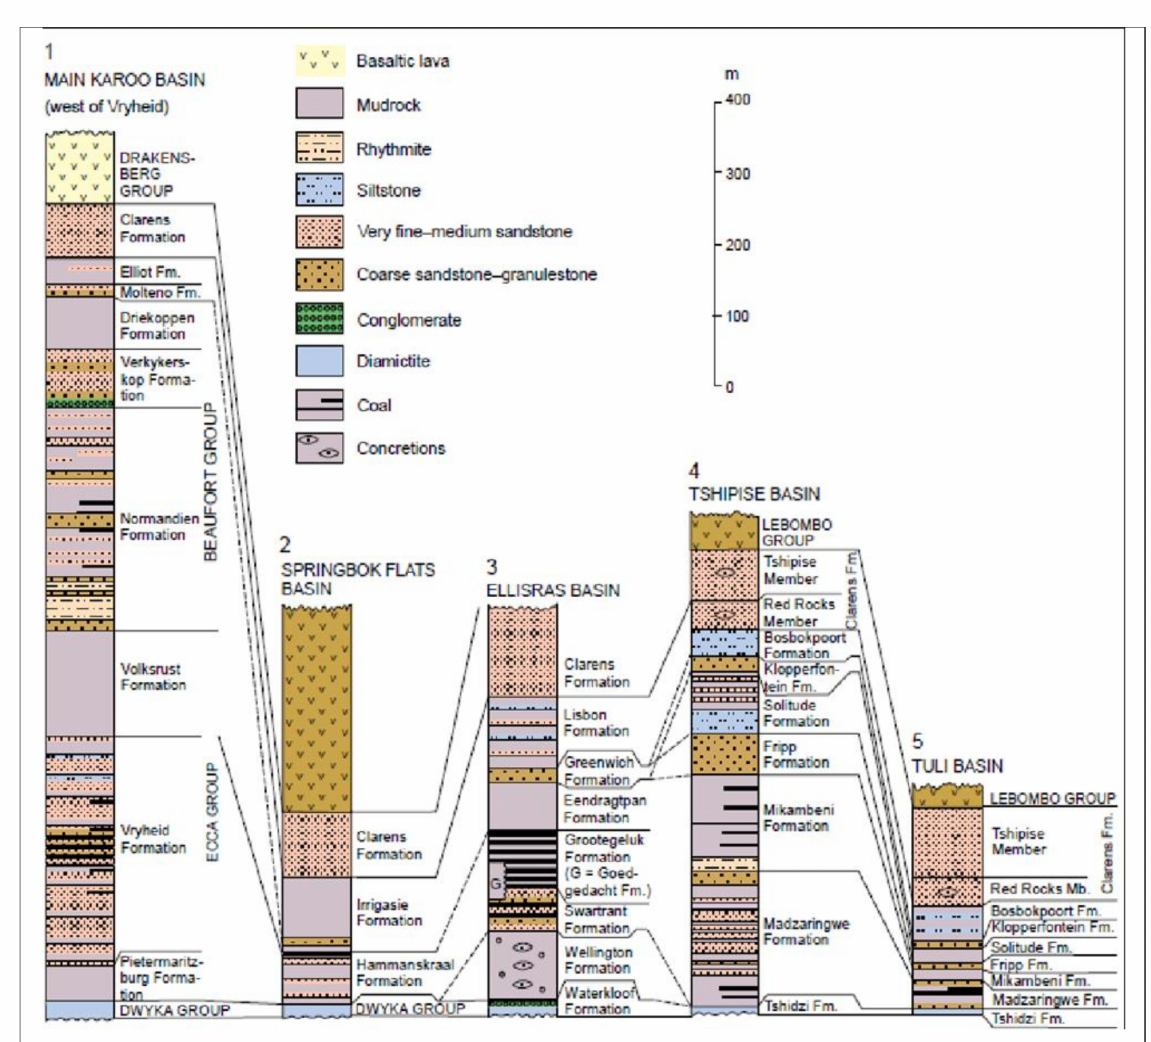
Figure 3. Stratigraphic correlation of the main Karoo Basin and the northern sub-basins